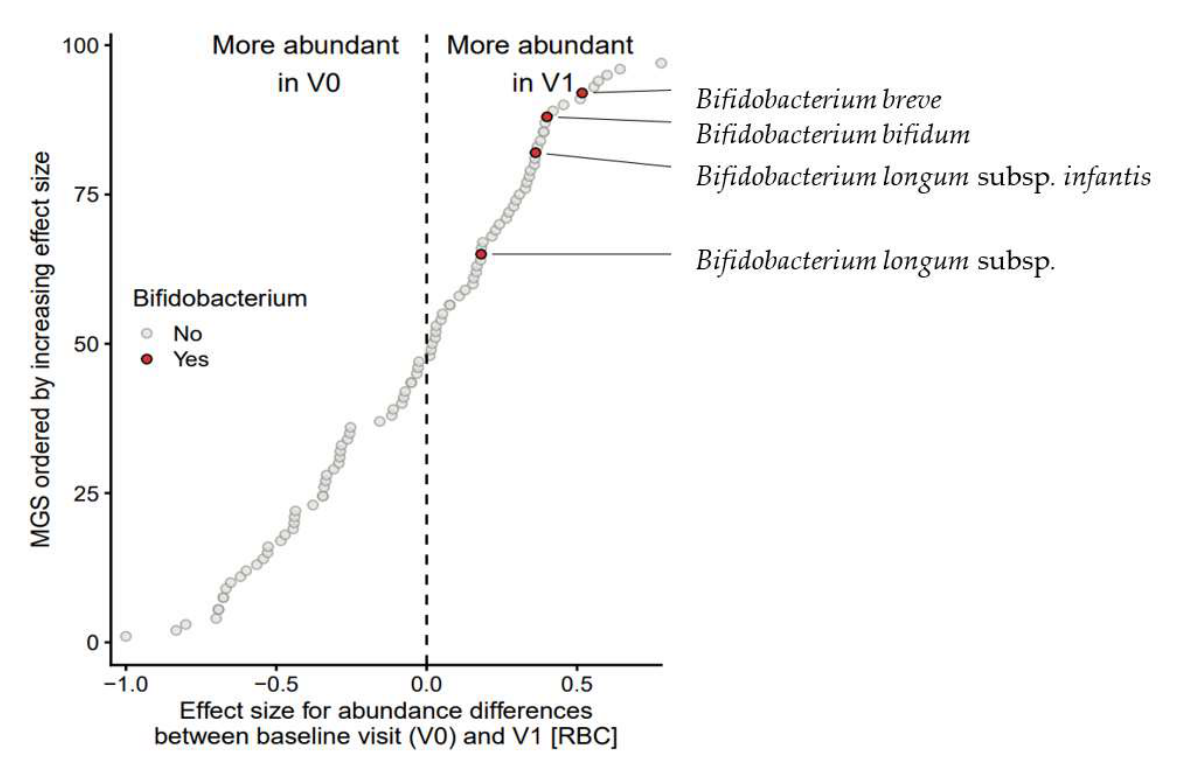
Figure 8. Taxon set enrichment analysis. Each circle represents the effect size (rank biserial correlation, RBC) of a single metagenomic species (MGS) when comparing the relative abundances between Visit 0 (V0) and Visit 1 (V1) in 28 infants with CMPA. The 97 included MGS ( Y -axis) are sorted by their corresponding RBC-value ( X -axis). Bifidobacterium (sub)species are highlighted in red. Fecal concentrations of the three SCFA, acetate, propionate, and butyrate, increased significantly from enrollment to 12 months of age (Figure 9). Relatively high levels of fecal acetate, a key metabolite of HMO-utilizing bifidobacteria, were found throughout the entire study to 12 months of age. Fecal butyrate levels increased progressively from V0 to V5, while propionate levels peaked at V4 and declined slightly towards